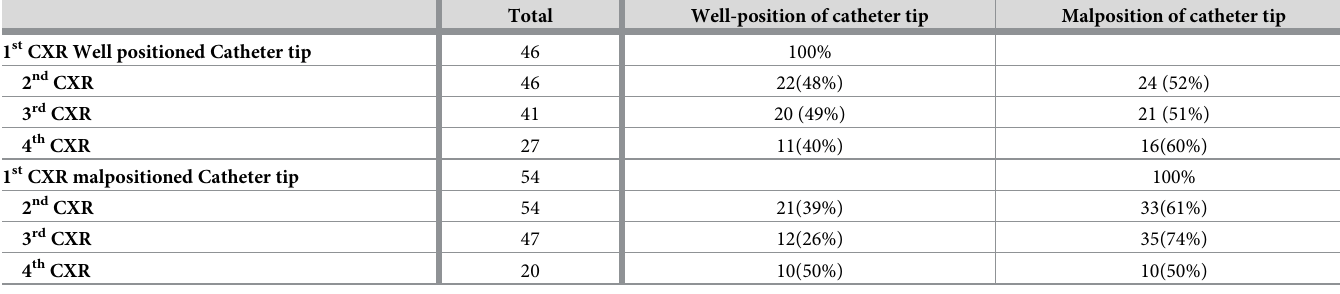
Table 2. Catheter tip positioning movement during hospitalization as shown in consecutive CXRs compared to initial position (1 st CXR). Total Well-position of catheter tip Malposition of catheter